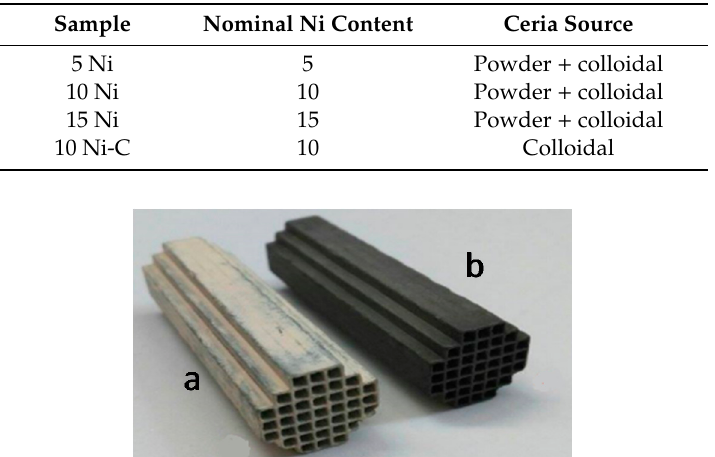
Figure 16. Silicon carbide (SiC) monolith washcoated with CeO 2 ( a ) and after Ni deposition ( b ).